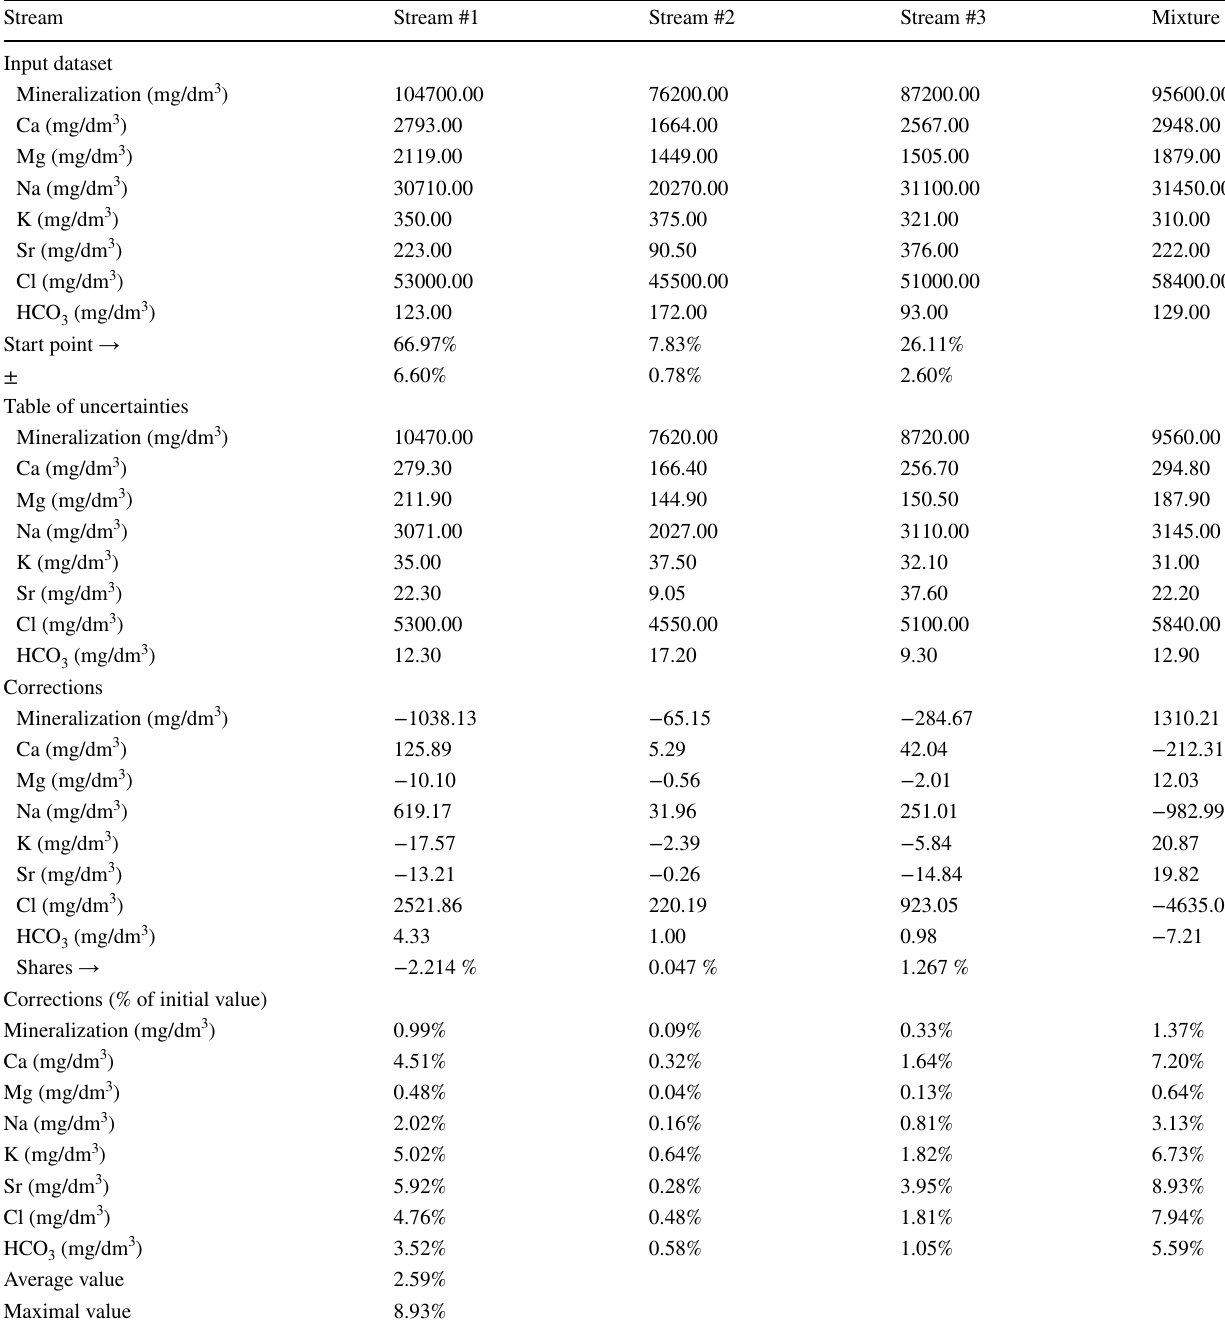
Table 2 The dataset describing subsequent stages of balancing the water system (level 700, Year 2) with the help of KYBL 7 software ‑